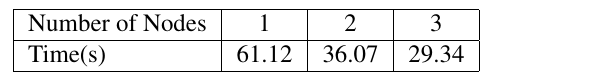
Table 1. Time it takes to create a 3GB dataset by di ff erent numbers of nodes in